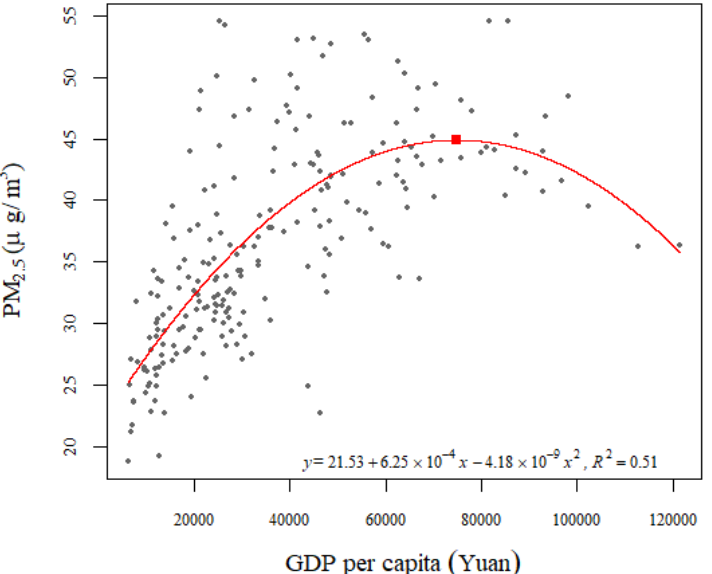
Figure 7. Scatter plot and Environmental Kuznets Curve (EKC) fitting line between PM 2.5 concentrations and GDP per capita.